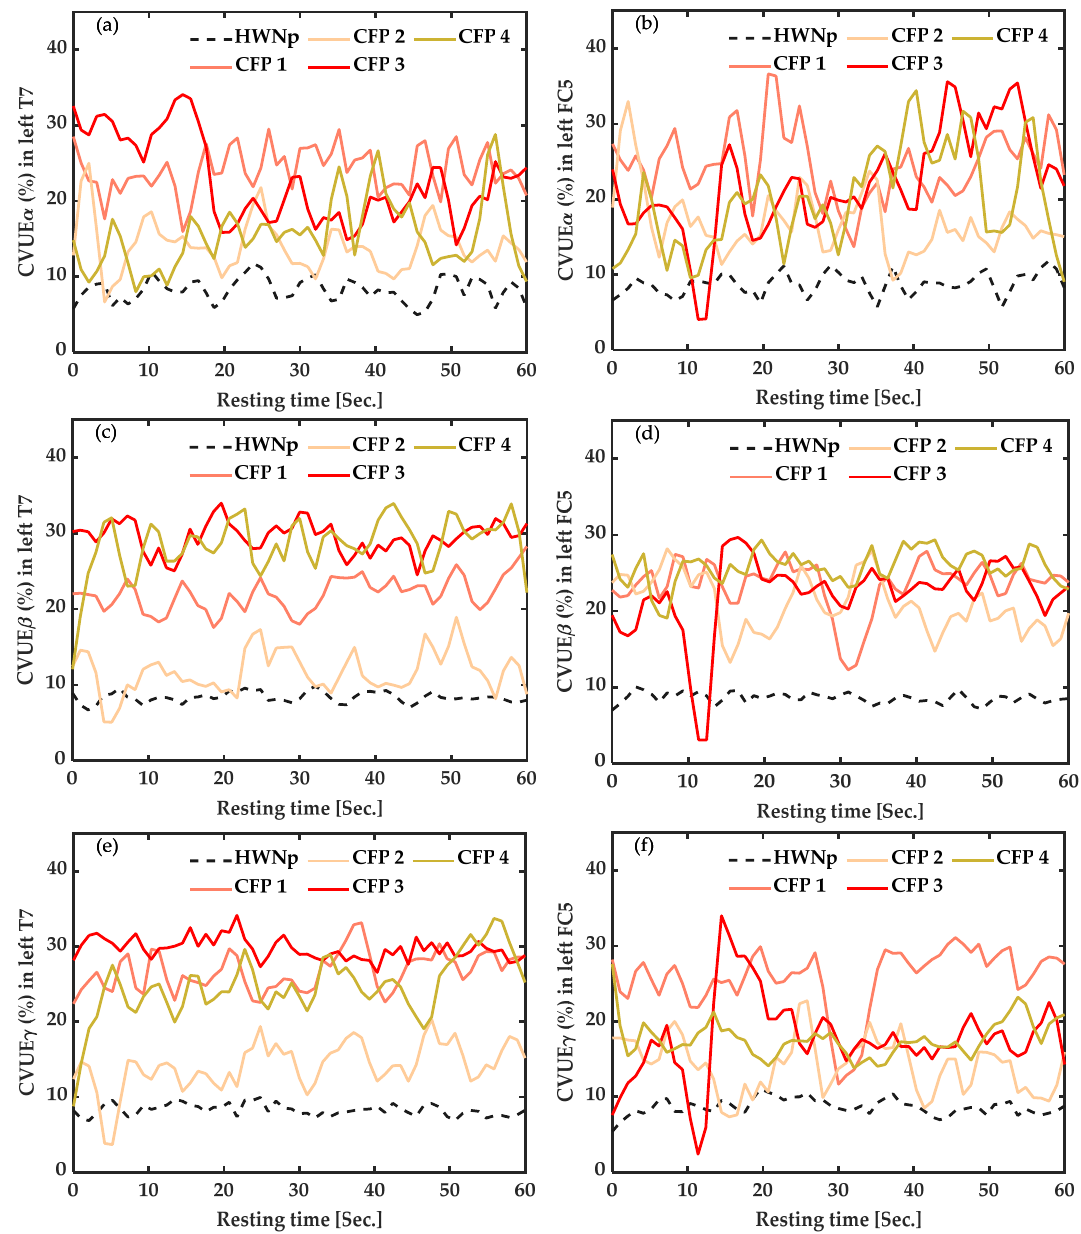
Figure 3. Baseline measures of the coefficient of variation of upper envelope (CVUE) in alpha (CVUE α ), beta (CVUE β ) and gamma (CVUE γ ), at rest. ( a )—CVUE α from left temporal (T7) data, ( b )—CVUE α from left fronto-central (FC5) data, ( c )—CVUE β from left temporal (T7) data, ( d )—CVUE β from left fronto-central (FC5) data, ( e )—CVUE γ from left temporal (T7) data, ( f )—CVUE γ from left fronto-central (FC5) data. The black dotted line indicates the average of CVUE of healthy with “No pain” (HWNp). The colored lines represent CVUE of the four participants with chronic fibromyalgia pain (CFP 1-4 ). The graphs were smoothed by a 5th-order of Savitzky–Golay filter. CVUE β from FC5 data was significantly increased in all CFP.